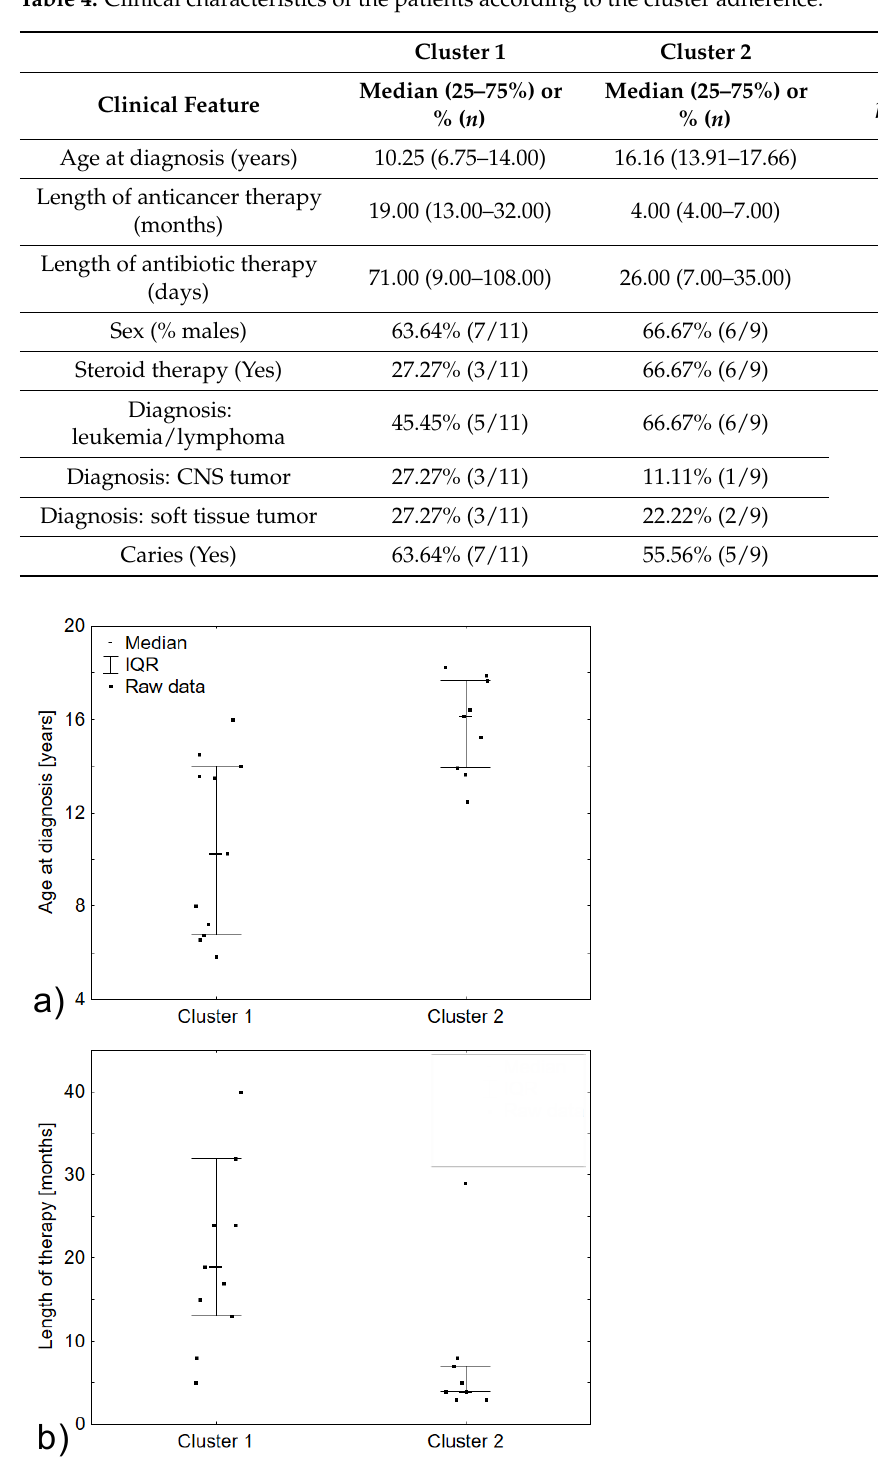
Figure 5. Clinical diversity of identified clusters: ( a ) difference in the age at diagnosis of patients from Cluster 1 and Cluster 2; p = 0.0049. ( b ) Difference in the length of anti-cancer therapy between patients from Cluster 1 and Cluster 2; p =